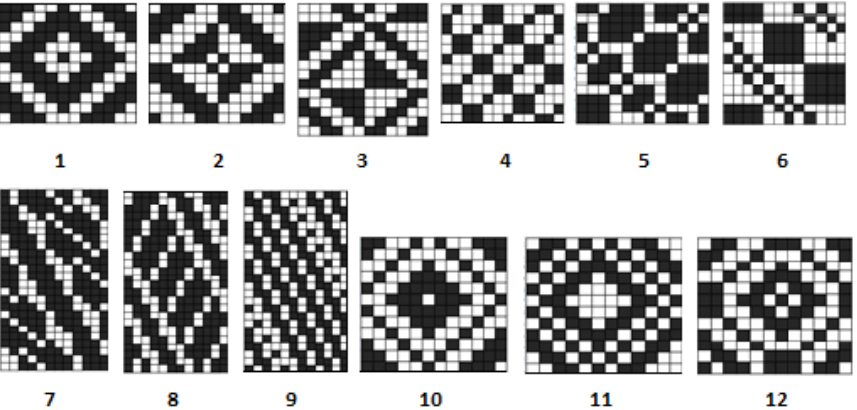
Figure 1 . Weaves used for the experiment: 1, 2, 3—diamond twills; 4, 5, 6—derived baskets; 7, 8, 9—derived twills; 10, 11, 12—honeycombs.